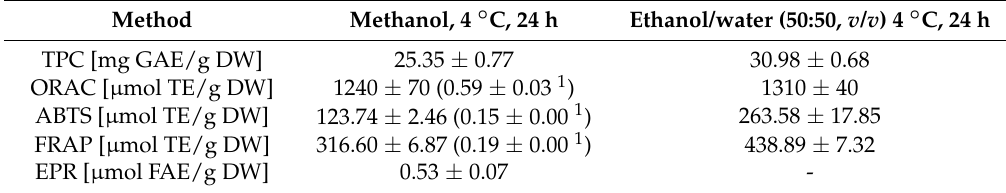
Table 2. Radical scavenging values of avocado seed extract (ASE) obtained with pure methanol and